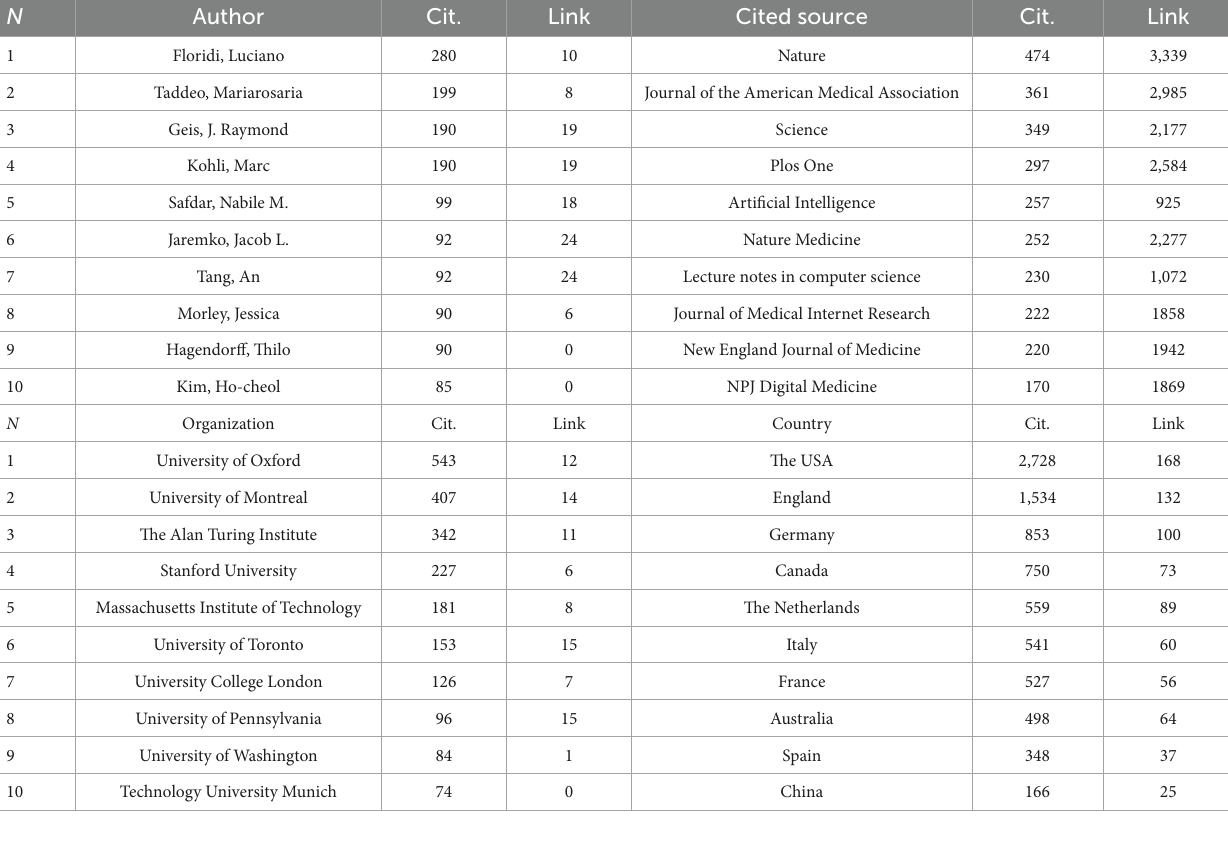
TABLE 2 Top 10 authors, sources, organizations, and